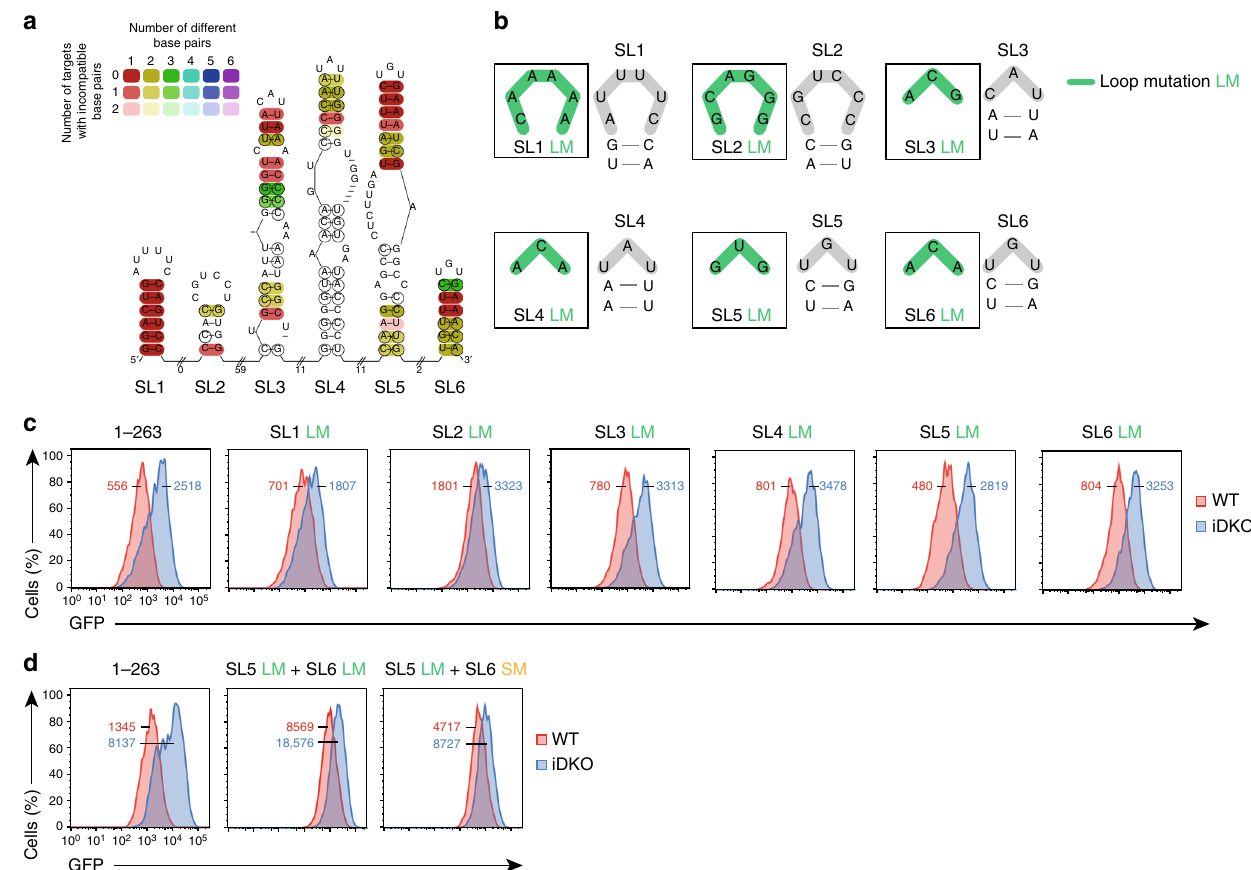
Fig. 3 Roquin interacts with the Nfkbid 3 ′ -UTR via multiple stem-loop structures. a Consensus secondary structure prediction of the minimal response element of the Nfkbid 3 ′ -UTR (1 – 263) by mLocARNA. Consensus sequences of SL1 (residues 19 – 36), SL2 (residues 37 – 50), SL3 (residues 112 – 132), SL4 (residues 161 – 175), SL5 (residues 214 – 230), and SL6 (residues 243 – 257) are represented. The color annotation is described in Fig.1b and Supplementary Fig. 3a. b Schematic representation of the six conserved SL structures within the 3 ′ -UTR of mouse Nfkbid . Wild-type loop structures (gray) of the six SLs were modi fi ed by individual loop mutations (LM: change of purine and pyrimidine bases, green). c , d Flow cytometry analysis of GFP in Rc3h1 – 2 fl / fl ; Cre- ERT2 MEF cells retrovirally transduced with the ICOS – GFP - Nfkbid 3 ′ -UTR (1 – 263) reporter without mutation, with individual LMs ( c ) or with combined LMs and stem mutation in SL6 (SL6 SM) ( d ). MEF cells were either treated with 4 ′ OH-tamoxifen (iDKO) or left untreated (WT). Median fl uorescent intensities (MFI) of GFP for WT (red) and iDKO (blue) MEF cells are indicated. Data are representative of six ( c ) and three ( d ) independent Introduction of either one or all three boxB stem – loops at the expected to enable more ef fi cient translation (Supplementary Fig. 5c, d). Blocking the deadenylation of this reporter mRNA fused to the 3 ′ -UTR of Nfkbid with a poly A-tail of 146 adenines (poly A 146 ) followed by ten cytosines (C 10 ) afforded increased expression in the absence of Roquin, but could not block Roquin- mediated repression (Fig. 5c, d). We then addressed the role of mRNA decapping in Roquin-mediated post-transcriptional gene regulation by transcribing the reporter encoding mRNAs either with a normal cap (m 7 G) or different cap-analogs (ARCA, D1, D2, and BH3) that were developed to confer insensitivity to Dcp2-mediated decapping 28 (Fig. 5e, f). Again, all cap analogs increased the reporter expression in the absence of Roquin, but were unable to prevent Roquin-induced repression (Fig. 5f). Importantly, simultaneously blocking deadenylation and decap-